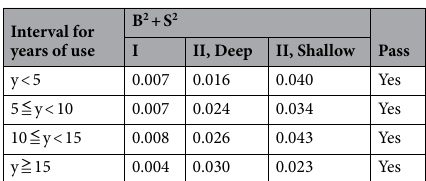
Interval for years of use